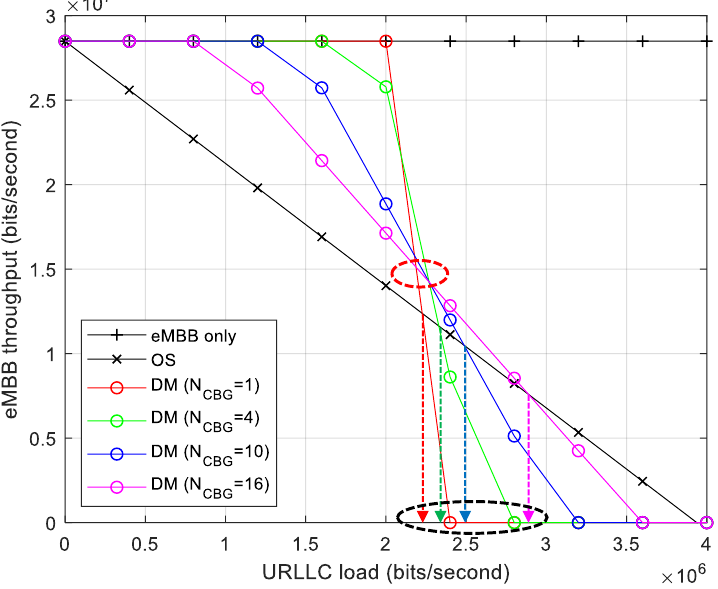
Figure 6. eMBB throughput comparison with different numbers of CBG N CBG